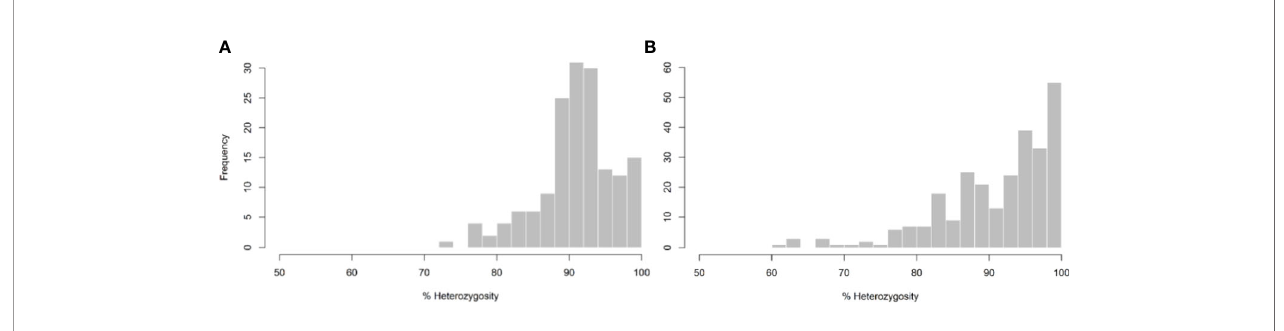
FIGURE 3 | Distribution of heterozygosity rates among markers (A) and diploid gametes (B) . TABLE 1 | Estimation of PHR of diploid gametes; percentage of gametes with full interspeci fi c heterozygosity, C. medica or C. micrantha homozygosity. Chromosome PHR Percentage of gametes with 100% restitution